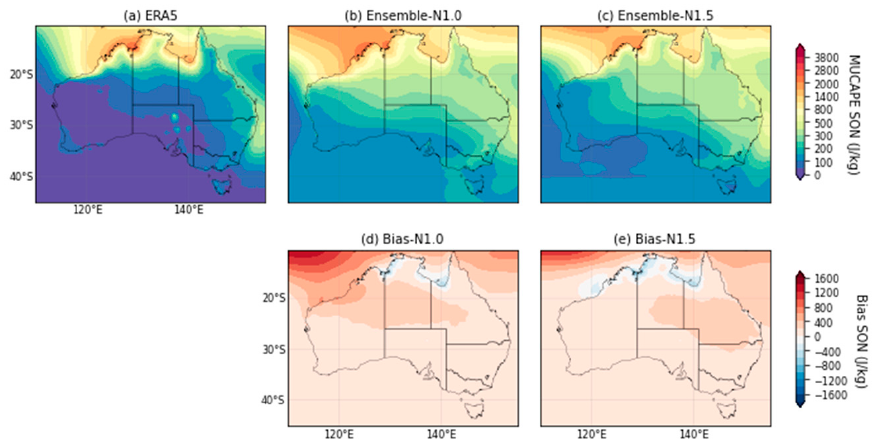
Figure A3. Climatology of MUCAPE in d01 from ( a ) ERA5, ( b ) N1.0 and ( c ) N1.5 during SON. ( d , e ) are the biases of N1.0 and N1.5 from ERA5, respectively. Unit: J kg − 1 .